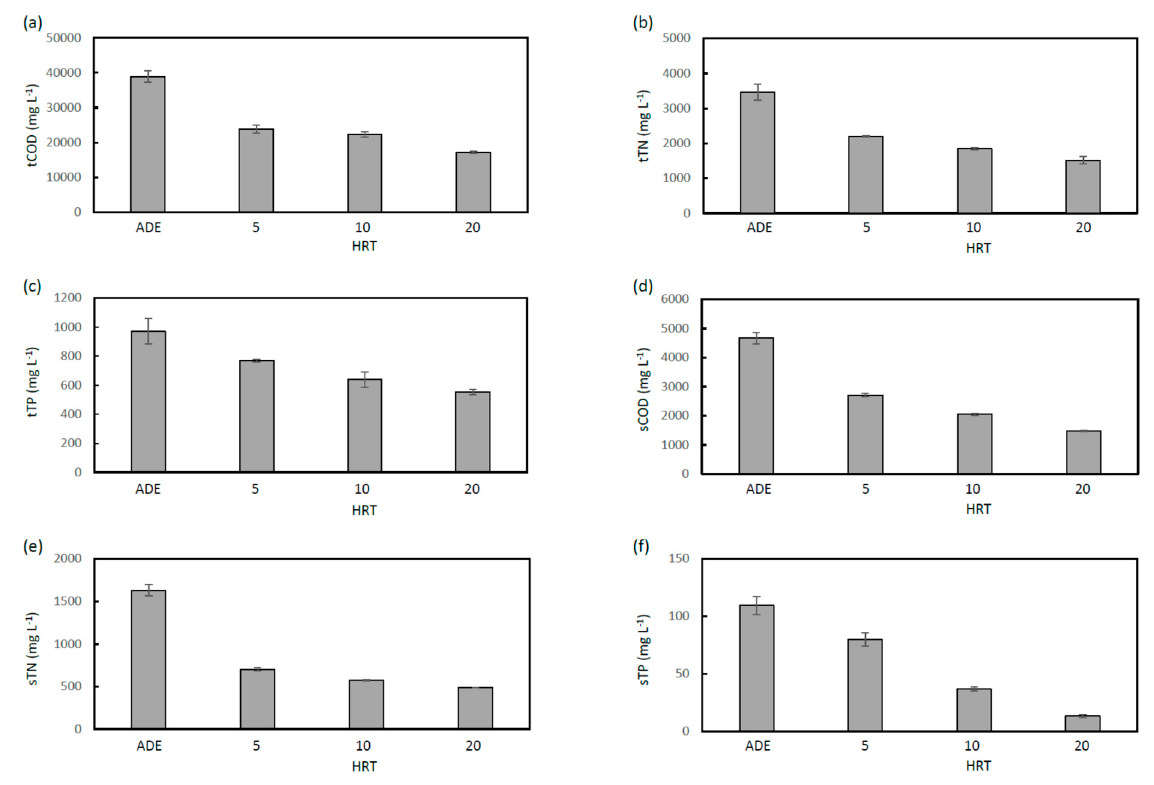
Figure 3. Total and soluble COD, TN and TP in MFCE from MFCs operated at HRTs of 5, 10 and 20 days. Data of tCOD ( a ), tTN ( b ), tTP ( c ), sCOD ( d ), sTN ( e ) and sTP ( f ) for MFCE removed from respective MFCs on day 40 are shown. These values for ADE are also presented in the graphs. Mean values and standard errors are shown (n = 3).